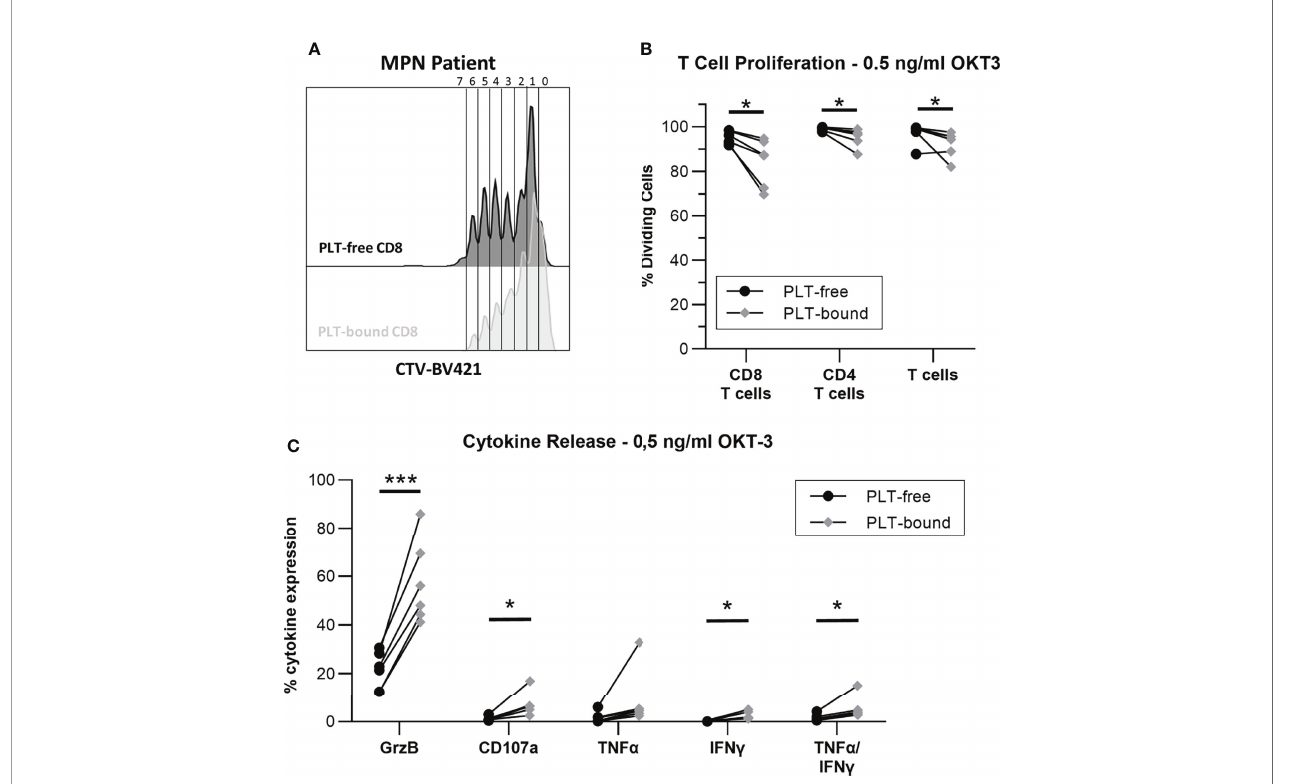
FIGURE 5 | In vitro PLT-bound CD8 T cells from MPN patients show decreased proliferation compared to PLT-free CD8 T cells. Cryopreserved samples from six MPN were stimulated with OKT-3 (0.5ng/ml) for fi ve hours (intracellular staining) or six days (Proliferation Assay). For the proliferation assay, PBMC were stained with CellTrace Violet ® (CTV) before OKT-3 stimulation. (A) A representative plot of the proliferation cycles in PLT-free (black) and PLT-bound (red) CD8 T cells is shown. (B) The frequency of proliferating PLT-free and PLT-bound CD8 T cells, CD4 T cells and total T cells are shown (n = 6) after fi ve-day stimulation. (C) The release of interferon-gamma (IFN- g ), tumor necrosis factor-alpha (TNF- a ) and Granzyme B (GrzB), as well as the expression of CD107a were compared in PLT-free and PLT- bound CD8 T cells (n = 6). All frequencies are shown as percentage of parent population. Paired T tests were used to compare PLT-free and PLT-bound frequencies and differences were considered signi fi cant when p < 0.05, as indicated with asterisks (*p < 0.05, **p < 0.01, ***p < 0.001, and ****p <